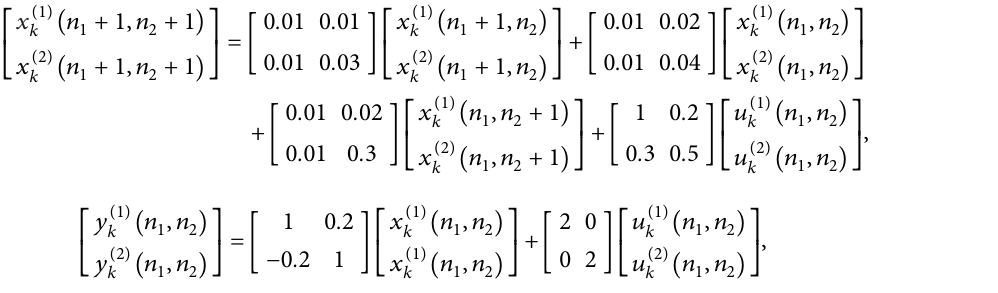
Figure 2: Tracking error surface e ( 1 )